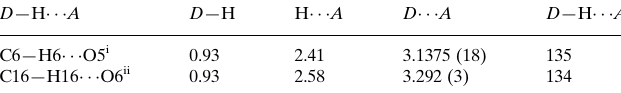
Hydrogen-bond geometry (A˚ , (cid:2)